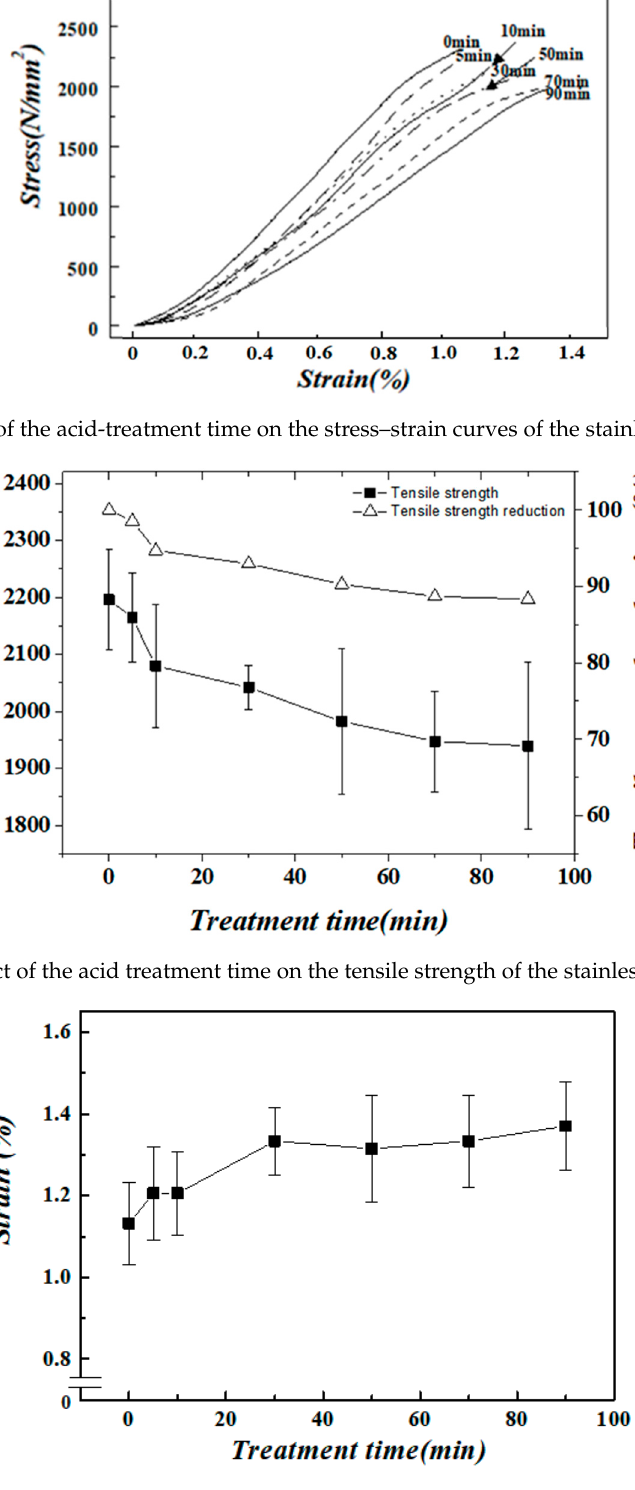
Figure 10. E ff ect of the acid-treatment time on the breaking strain (%) of the stainless-steel Figure 10. Effect of the acid-treatment time on the breaking strain (%) of the stainless-steel fiber. Figure 10. Effect of the acid-treatment time on the breaking strain (%) of the stainless-steel fiber. Figure 10. Effect of the acid-treatment time on the breaking strain (%) of the stainless-steel fiber.